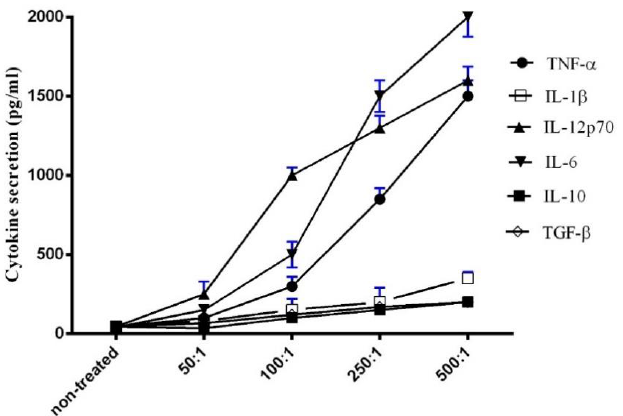
Figure 3. Heat-killed L. casei IMAU60214 dose-dependently enhances pro- and anti-inflammatory cytokine production by MDMs. The effects of L. casei IMAU60214 exposed at various ratios (50:1, 100:1, 250:1, 500:1) for 24 h on cytokine release were assessed by ELISA. Tumor necrosis factor (TNF)- α , interleukin (IL)-1 β , IL-6, IL-12p70, IL-10, and transforming growth factor (TGF)- β . Each value represents the mean ± SD of four independent experiments.